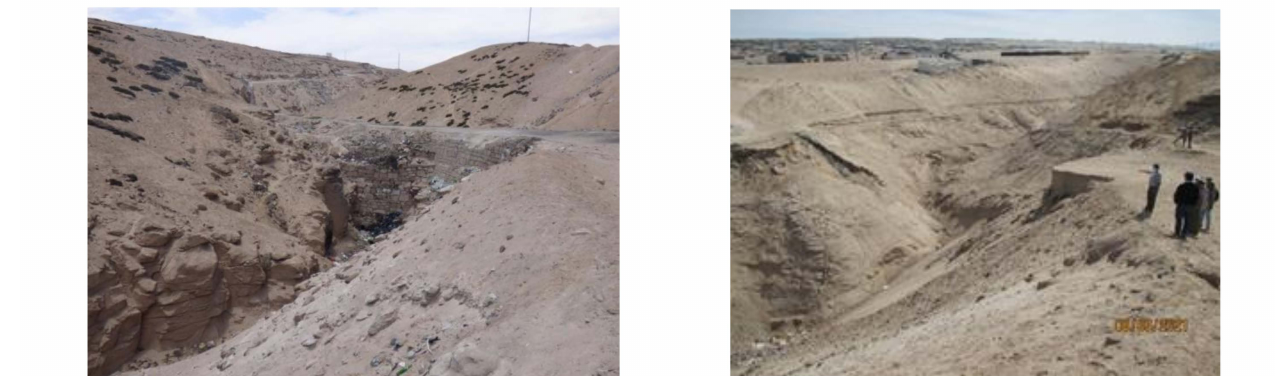
Figure 28. Before and after the Devil’s Creek channel was obstructed by an informal embankment as an access trail to farms in the Alto de la Alianza hill.